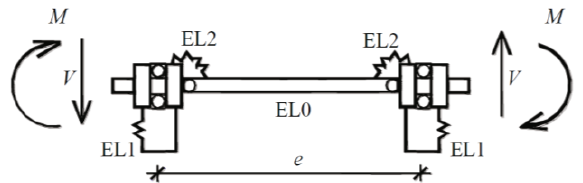
Figure 3. Modeling of the link (Bosco et al.,